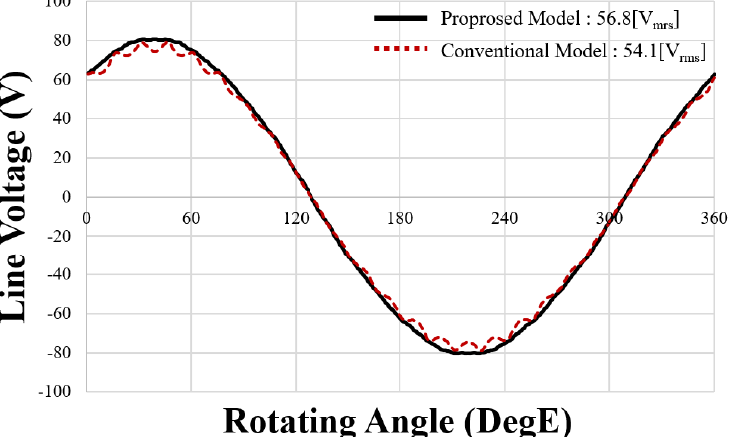
Figure 9. Comparison of no − load line voltages of the conventional and proposed